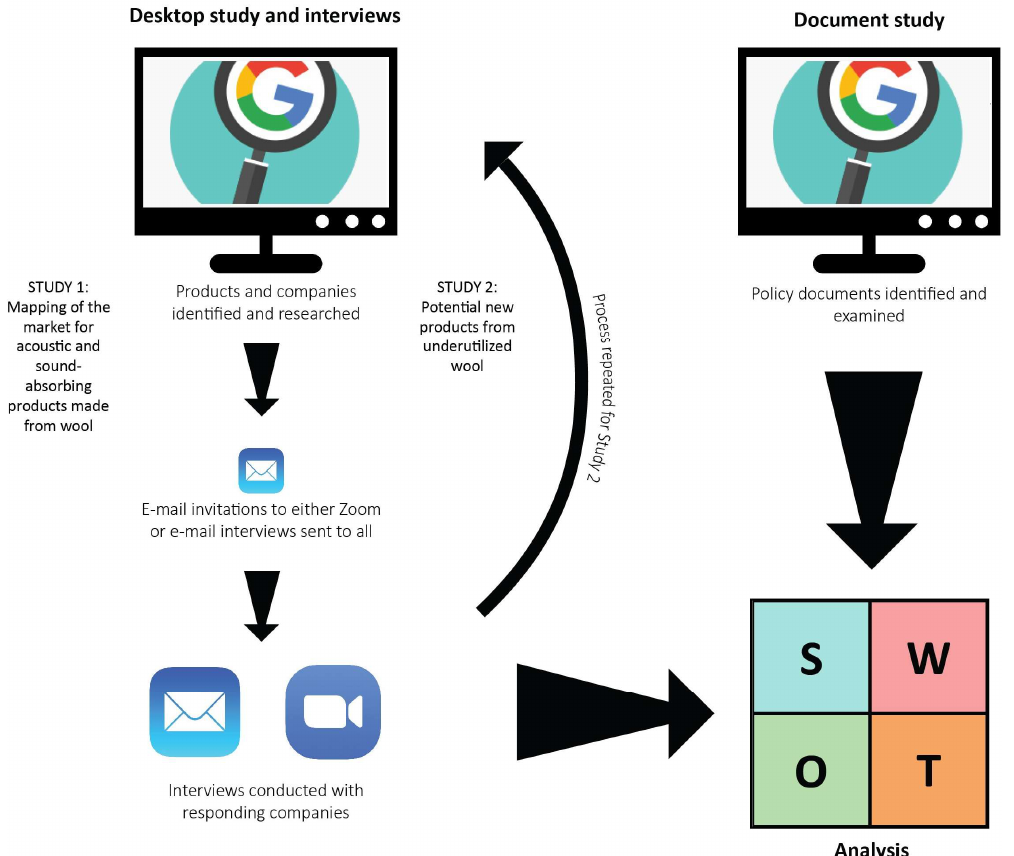
Figure 1. Research design. Data from desktop studies and interviews were combined with data policy document analysis in a SWOT analysis of the market for coarse wool products vs. products made of synthetic materials.